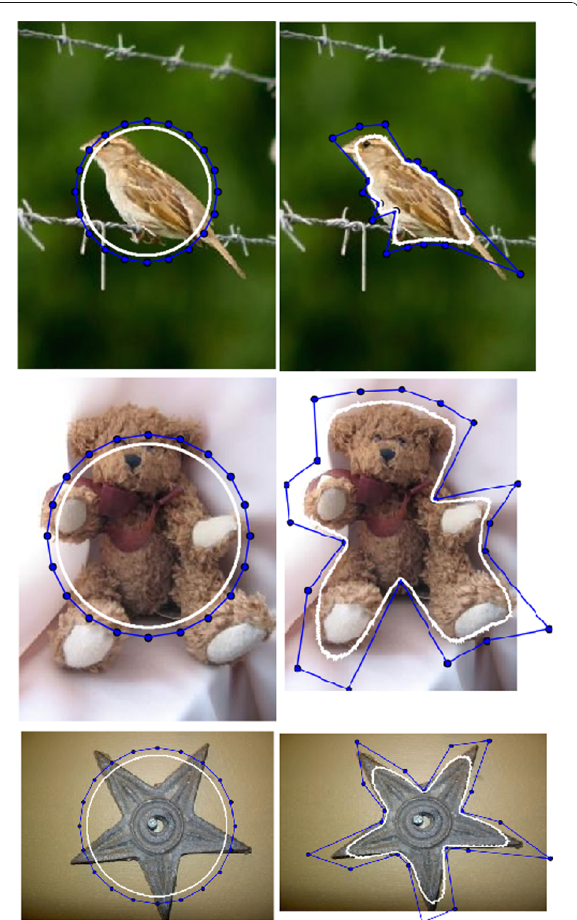
Fig. 6 Segmentation results. First column: initial contour (continuous white circle) and cage (polygon with 20 points). Second column: resulting contour (continuous white closed curve) and cage (deformed polygon) using the multivariate Gaussian mixture energy function. In the second column, image sizes have been scaled so as